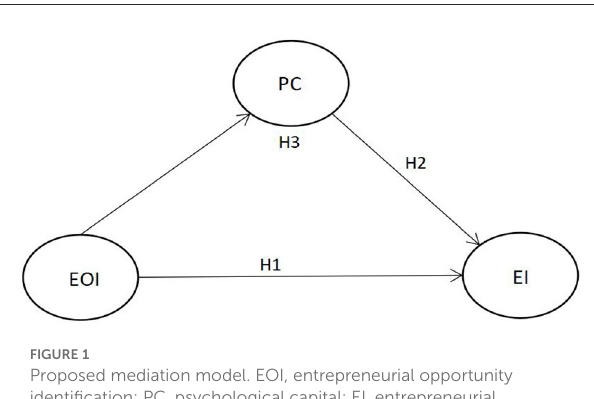
FIGURE1 Proposed mediation model. EOI, entrepreneurial opportunity identification; PC, psychological capital; EI, entrepreneurial